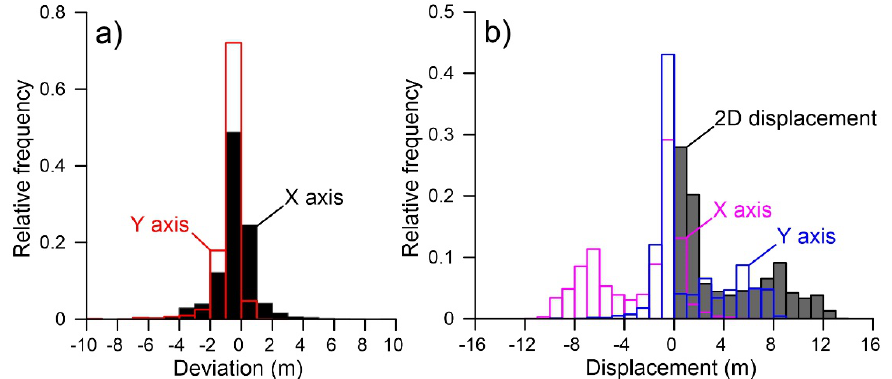
Figure 5. Slumgullion landslide and surrounding slopes. ( a ) Distribution of deviation in displacement estimation as derived by feature tracking in non-moving zones. ( b ) Distribution of displacement components and 2D total displacement as estimated by feature tracking within both the moving and non-moving zones.